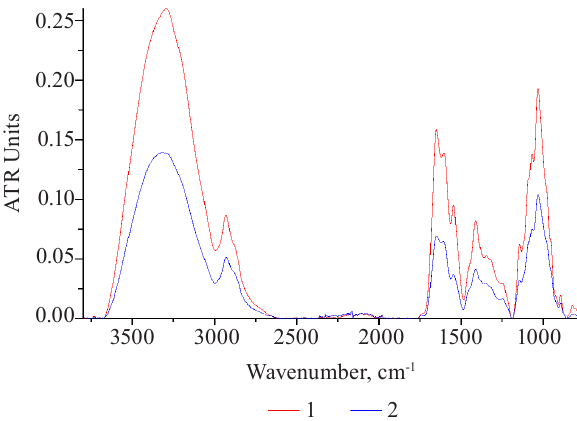
Figure 6 IR-spectra of PS-complexes of the secondary extraction of industrial flax seeds in a neutral medium: (1) 17.0, (2) 10.2% of protein